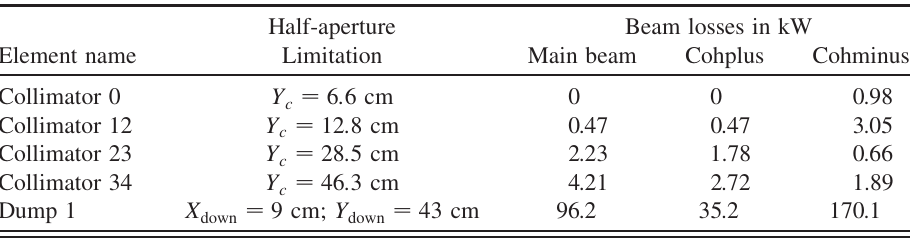
TABLE V. Power losses for the disrupted beam and for the coherent pairs in the collimators and the intermediate dump.